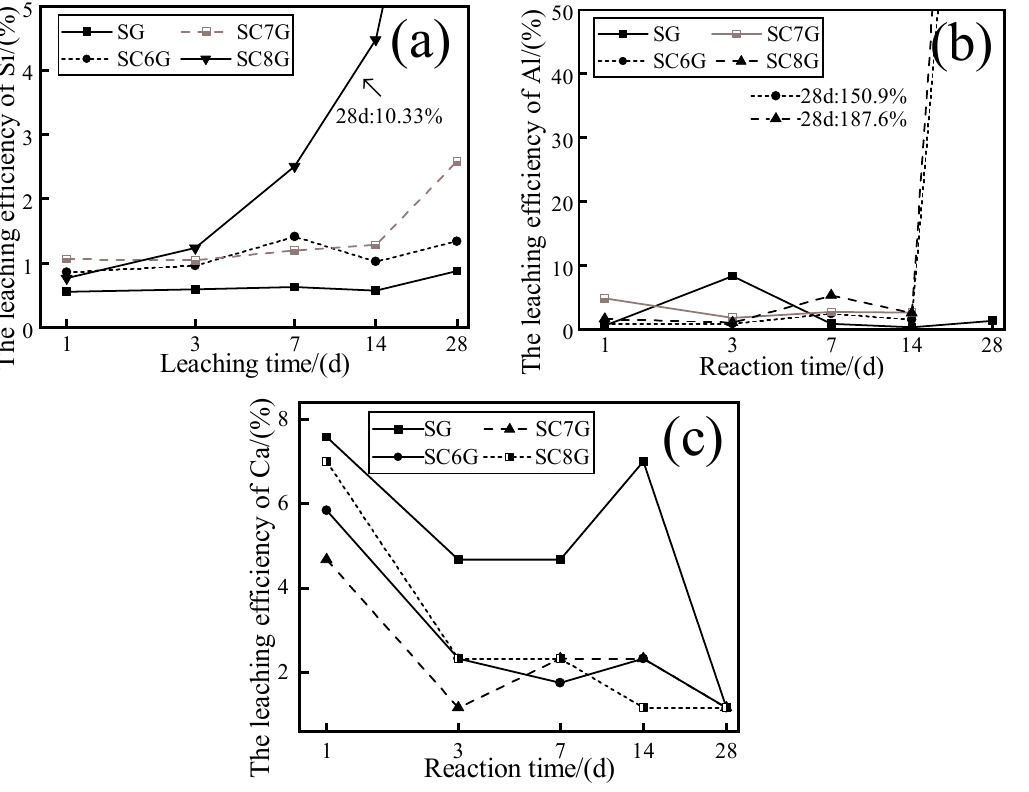
Figure 7. The e ff ect of di ff erent temperatures of thermal activation on the leaching e ffi ciency. ( a ) The Figure 7. The effect of different temperatures of thermal activation on the leaching efficiency. ( a ) The ion leaching e ffi ciency of Si, ( b ) the ion leaching e ffi ciency of Al, and ( c ) the ion leaching e ffi ciency ion leaching efficiency of Si, ( b ) the ion leaching efficiency of Al, and ( c ) the ion leaching efficiency of Ca. of